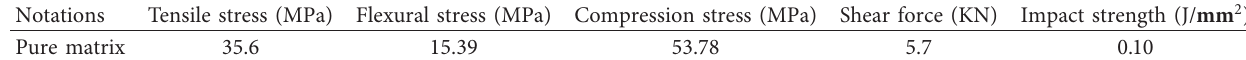
Table 9: Properties of the pure matrix.